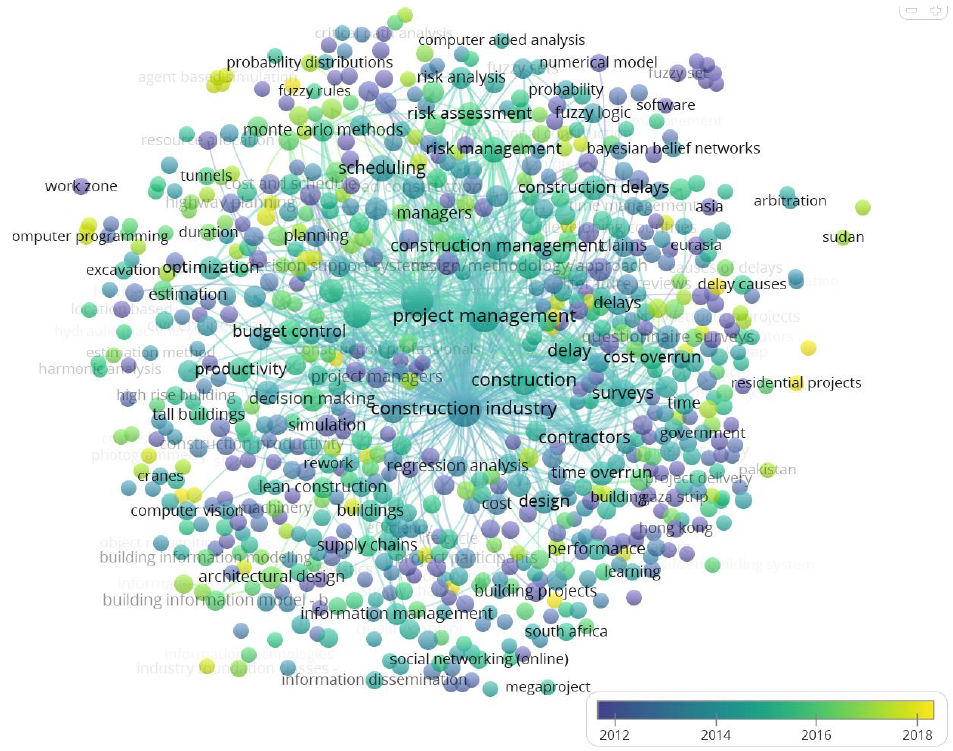
Figure 3. Co-occurrence analytical map of keywords created on the first bibliographic dataset. With the minimum number of co-occurrence of 2, a total of 713 keywords out of the sample of 2926 keywords are